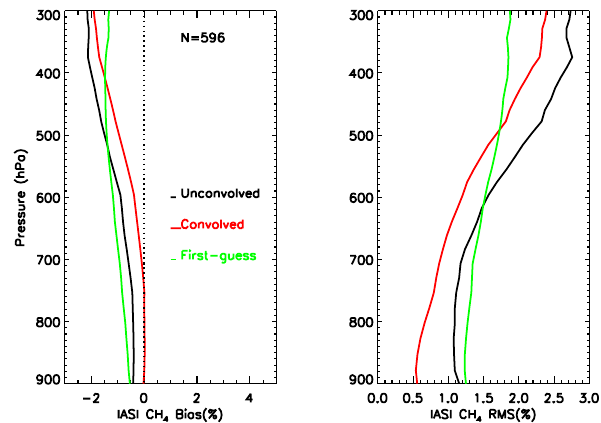
Fig. 9. Bias (left panel) and RMS errors (right panel) of the IASI- retrieved CH 4 mixing ratio and the first guess profile as compared to aircraft profiles from